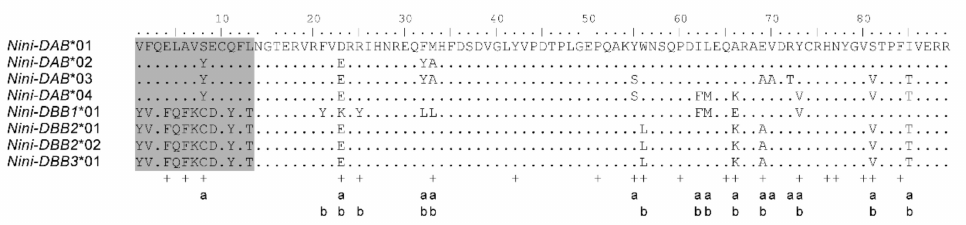
Figure 3. Amino acid alignment of the exon 2 of full-length Nini -II β sequences. Dots indicate identity to DAB *01. Crosses represent putative antigen binding sites (ABS) inferred from Jardetzky, et al. [60] and Stern, et al. [61]. “a” and “b” denote sites under positive selection for DAB and DBB s, respectively, as estimated by omegaMap.